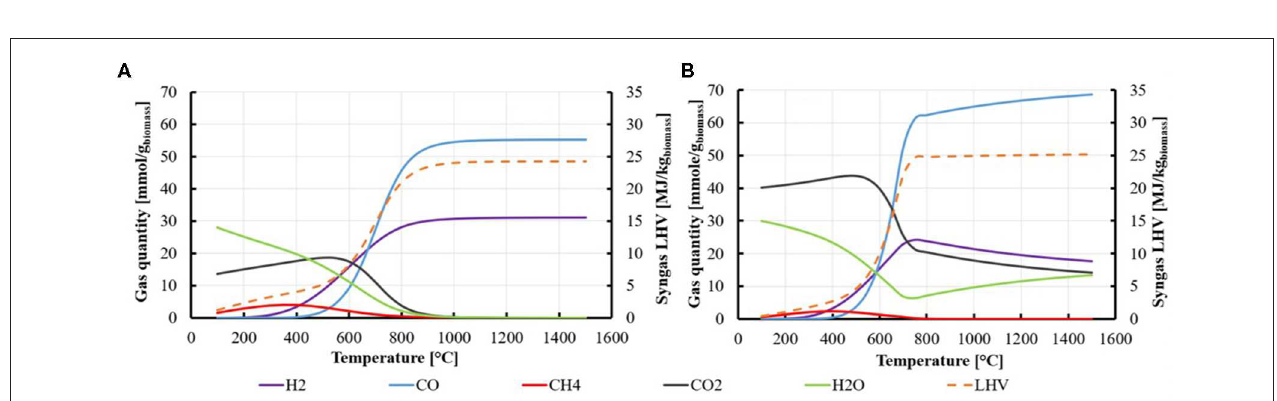
FIGURE 1 | Quantity of gases produced at thermodynamic equilibrium per gram of dry biomass from steam gasification of wood according to temperature: (A) stoichiometric proportion C